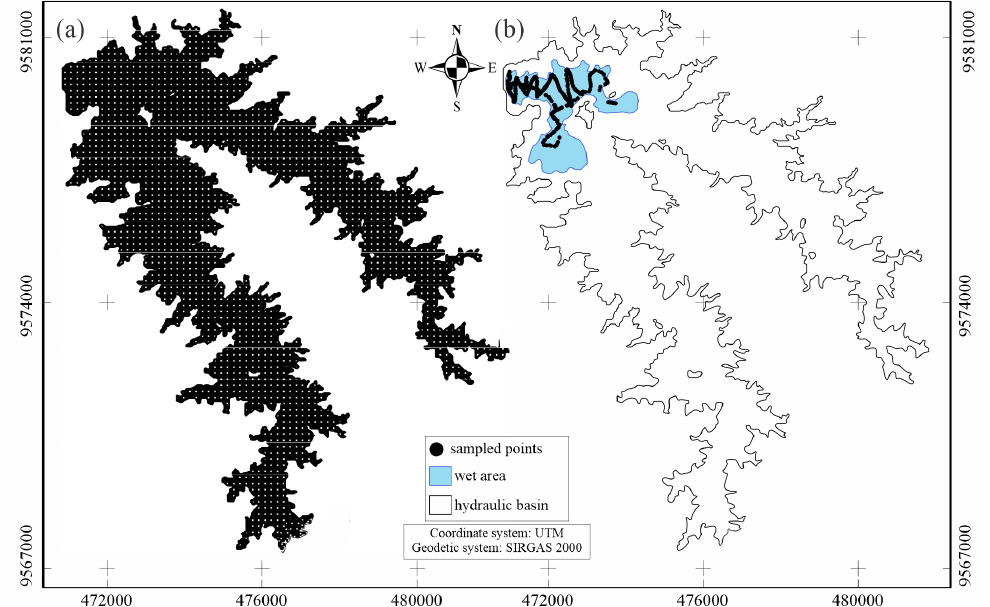
Figure 4. Spatial distribution of points shown on the Pentecoste reservoir by: ( a ) the conventional bathymetric survey method (CBS: it is not possible to view the separate points due to their high density); and ( b ) the bathymetric survey using remote sensing simplified method (BRS (bathymetric survey and remote